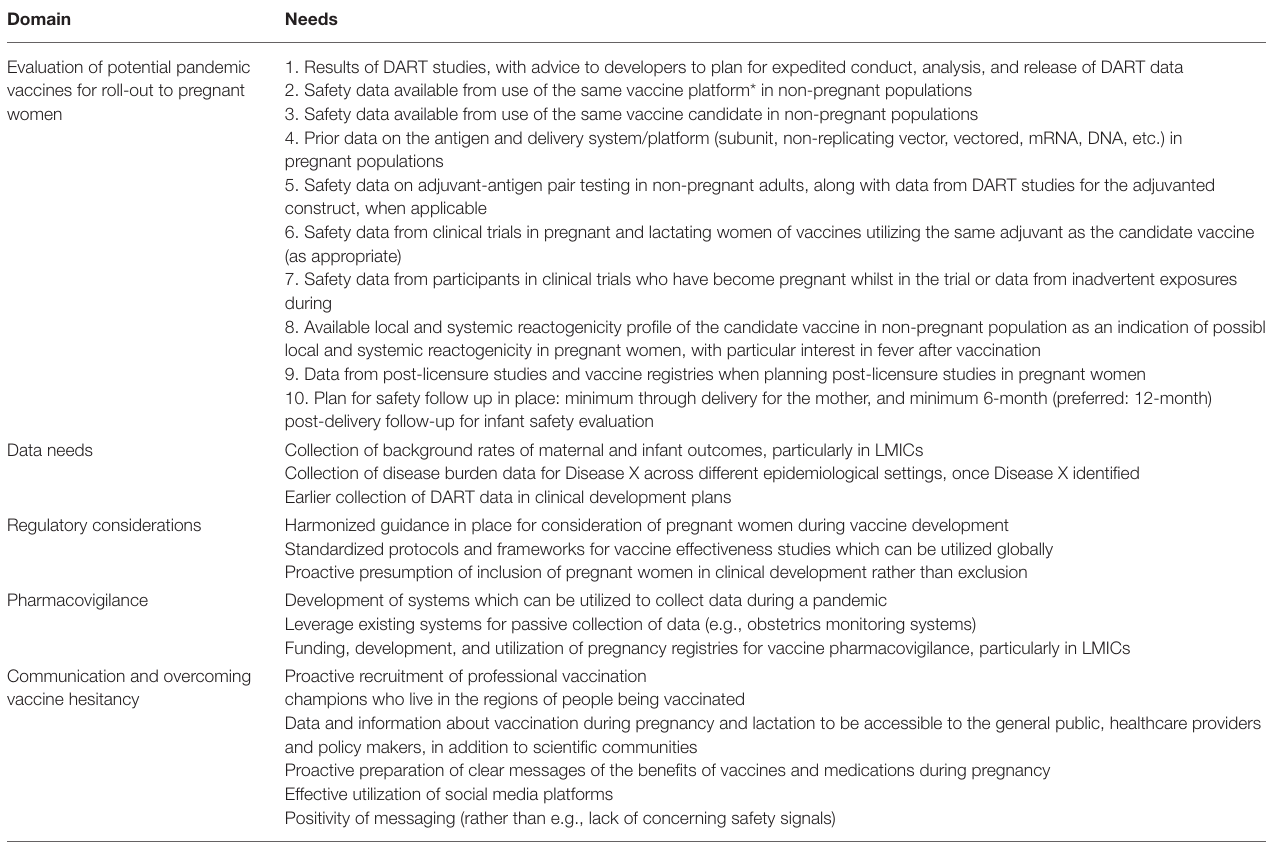
TABLE 1 | Lessons learned from the COVID-19 pandemic: pro-active planning considerations for Disease X.